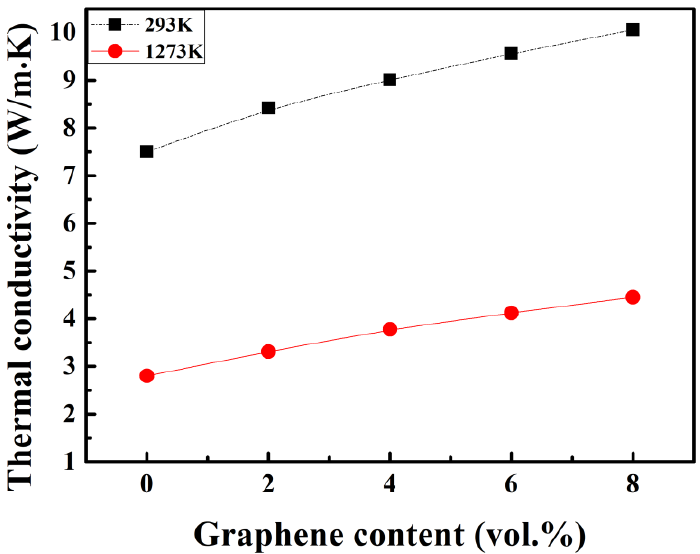
Figure 6. Influence of graphene content on the pellet thermal conductivity.